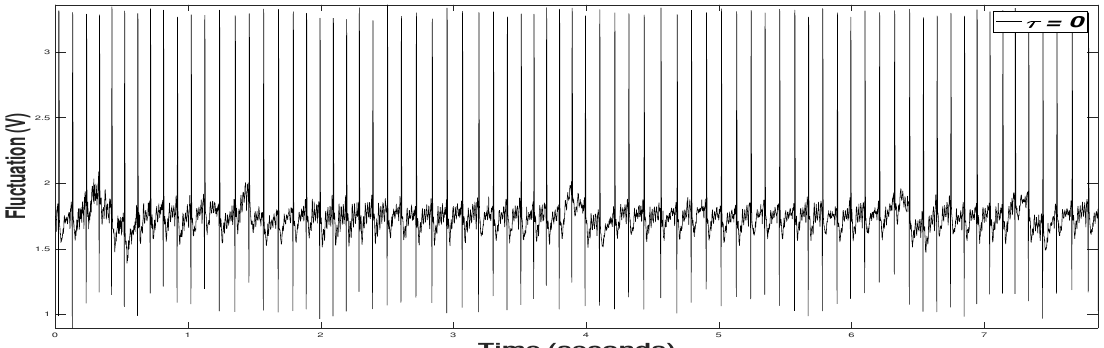
Figure 23. Original Time Series or RAW samples from ECG S